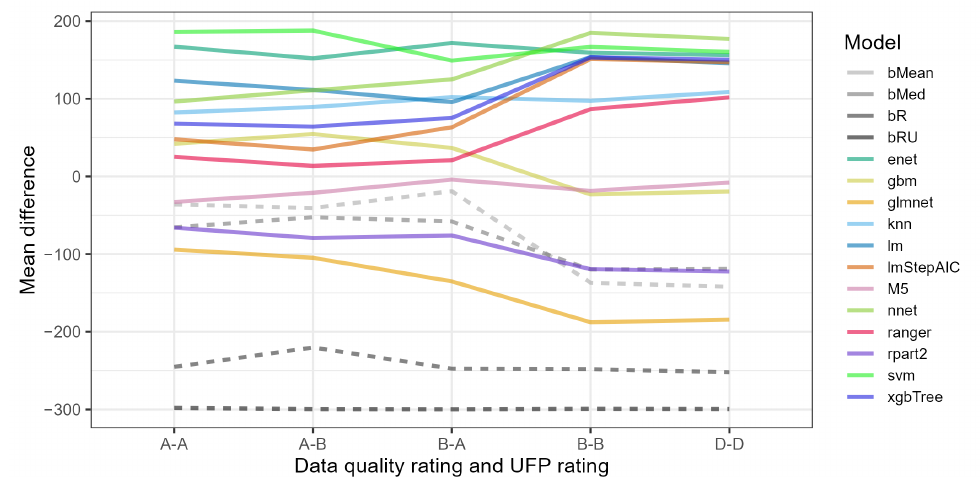
Figure 4. Mean difference of models for various data quality and UFP ratings. Each data point denotes a mean difference of a particular model for a given combination of Data Quality Rating and UFP Rating across all values of thresholds for fractions of valid values in all passes.